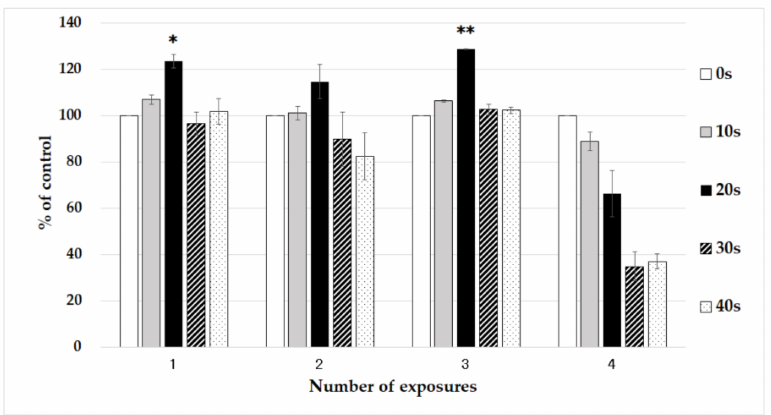
Figure 2. Direct effects of non-thermal atmospheric pressure plasma (NTAPP) on the proliferation of human deciduous dental pulp fibroblast-like cells (hDDPFs). These hDDPF (1 × 10 4 cells per well) were incubated for 96 h at 37 ◦ C and 5% CO 2 in 24-well plates and then treated 1, 2, 3, or 4 times with NTAPP for 10, 20, 30, or 40 s per h. NTAPP-treated cells were incubated for 72 h at 37 ◦ C and 5% CO 2 . Cell proliferation was measured using the MTS assay. Data are presented as means ± SE ( n = 4). Markers * and ** indicate significant differences at p < 0.05 and p < 0.01,